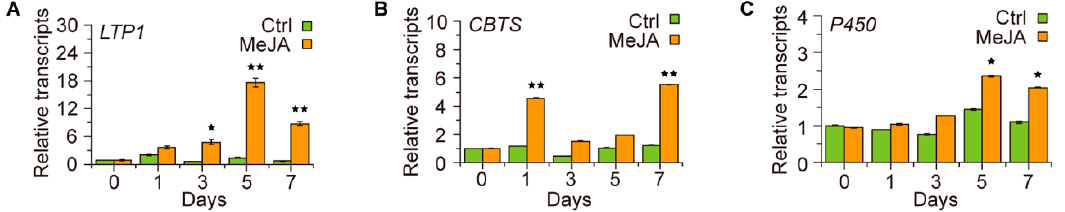
Figure 3. Effects of JA-treatment on the expression level of LTP1 , CBTS and P450 genes. ( A – C ) MeJA-induced transcription profiles of the cembranoid synthetic genes LTP1 , CBTS and P450 . Ctrl, plants of control treatment with H 2 O; MeJA, plants of MeJA treatment for indicated time points. The transcription level of each gene in the plants of control treatment at the “0” time point was arbitrarily set as “1”; values in ( A – C ) are the average of data from three plants with triplicate measurements. Asterisks indicate significant difference to the control treatment of the same time point in ( A – C ). Error bars, mean ± SE.